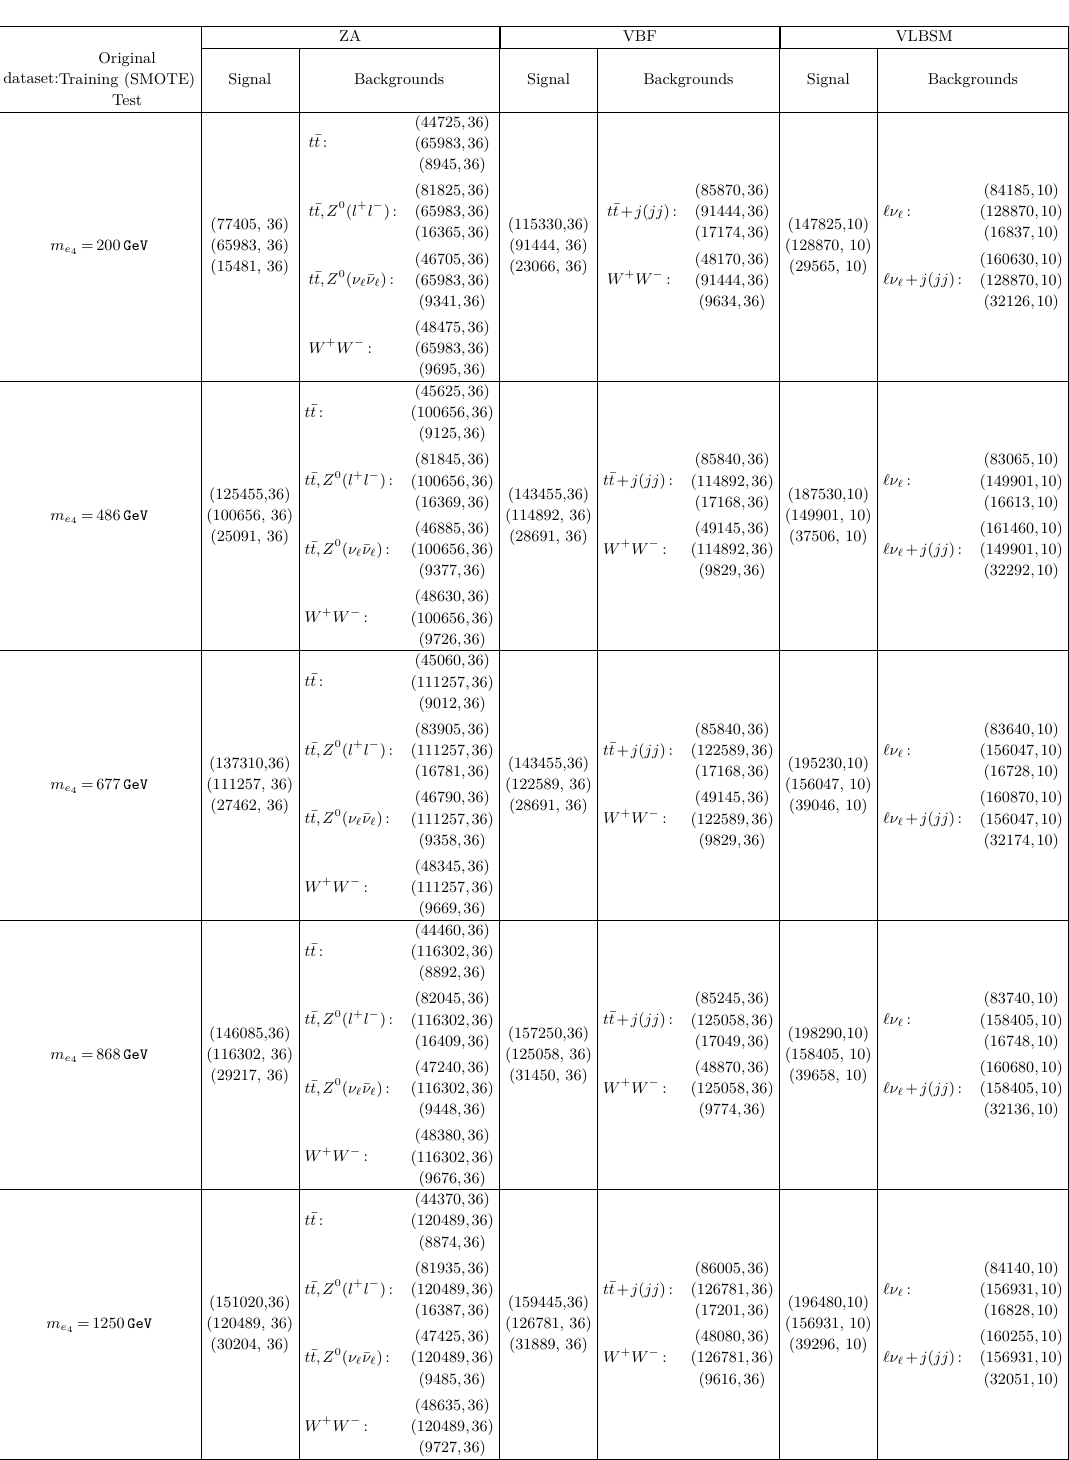
. In the pairings ( X, Y ) , 4